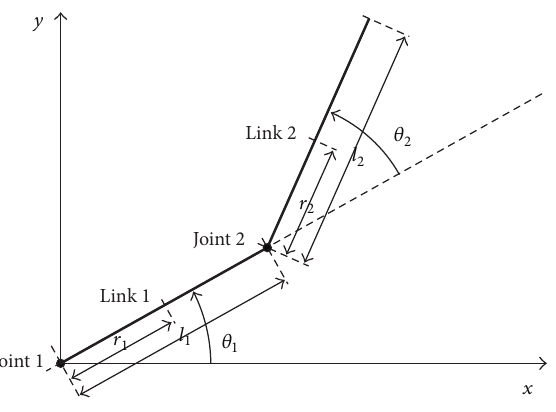
Figure 1: An underactuated two-link robot manipulator that moves in a horizontal plane in which only one of the joints is